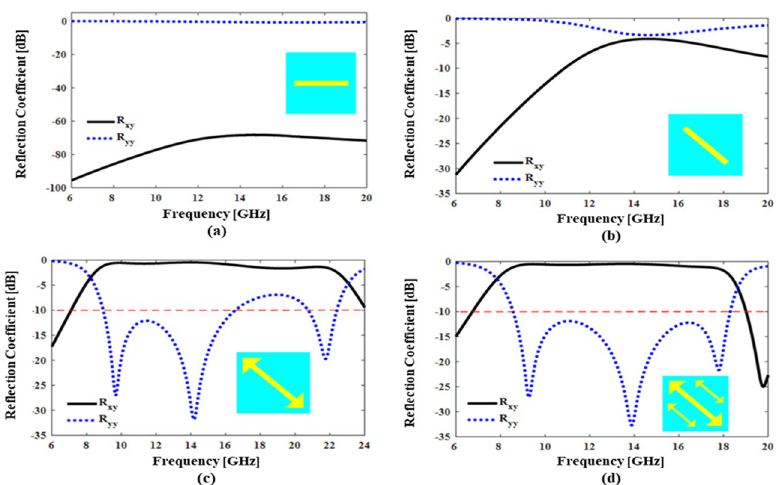
Fig 2. Co- and Cross polarized reflection coefficient for (a) horizontal line (b) diagonal line (c) single arrow shaped split ring resonators (d) triple- arrows shaped split ring